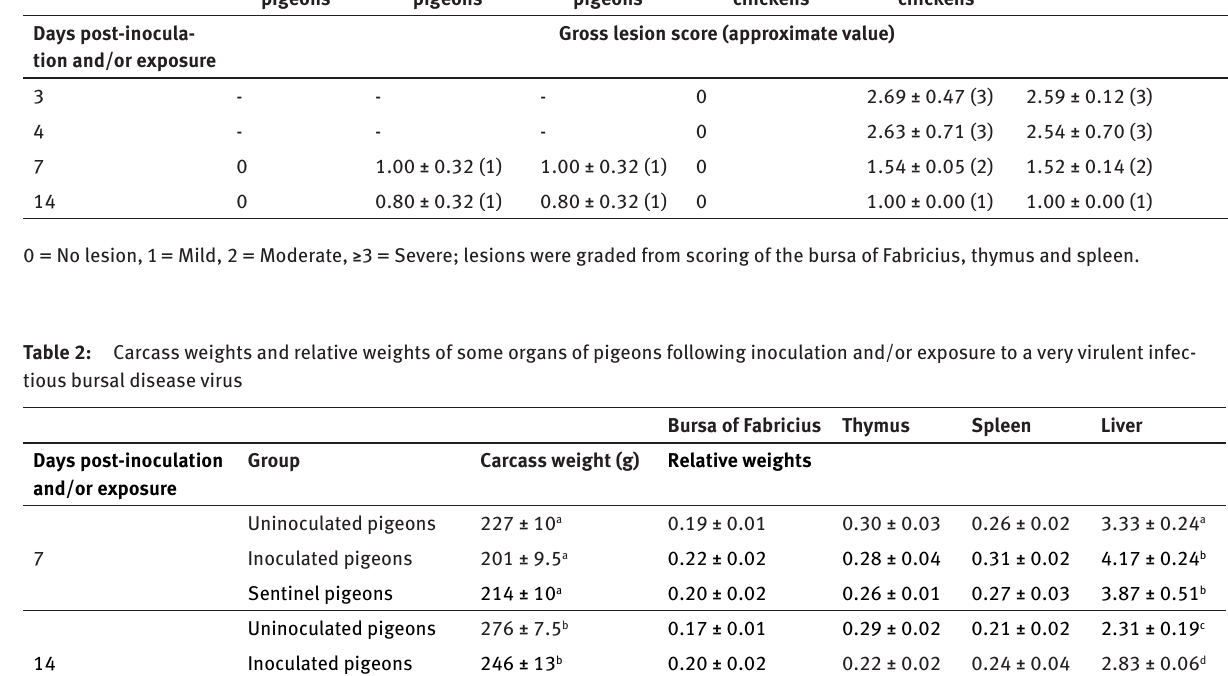
Values with different superscript alphabets along the same column differ significantly at P < 0.05.